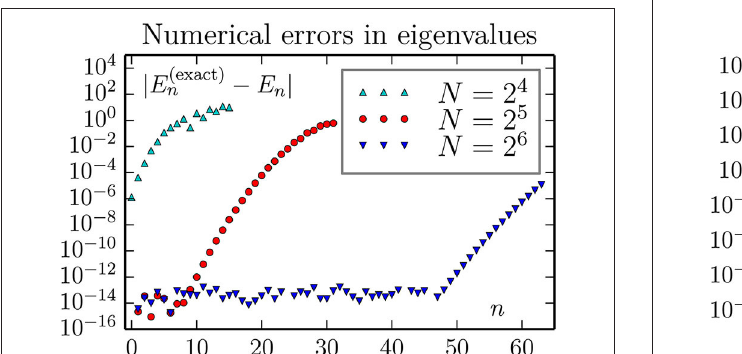
FIGURE 11 | Accuracy of computed eigenvalues for a 3 D oscillator, using the FFT approximation for kinetic energy T . As can be seen, a large number of the lowest eigenvalues can be computed to an absolute accuracy in the range 10 − 14 to 10 − 12 with lattice of size 2 6 2 6 2 6 . We observe no improvement × × by going to 2 7 2 7 2 7 lattice, but no harm either (except for an increase in × × 2 6 . the wall clock execution time from about 6 to 95 min for each combination of = boundary